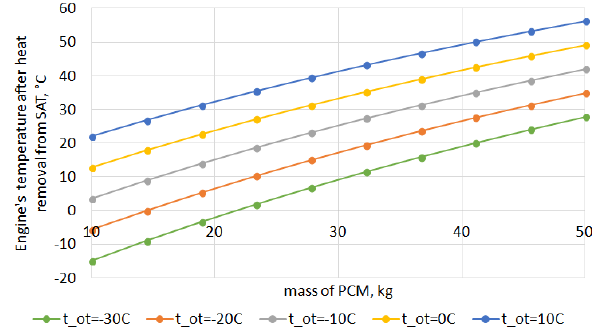
Fig. 16. Engine’s temperature in relation to heat storage